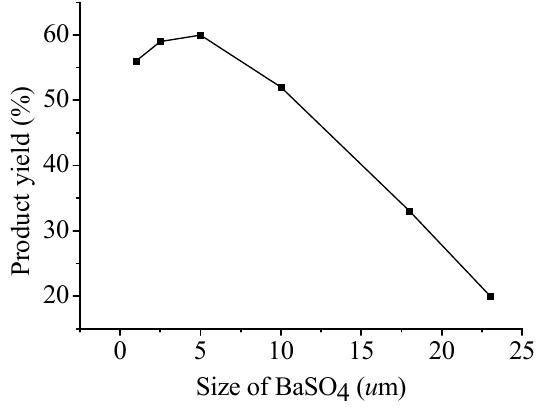
size on product 4